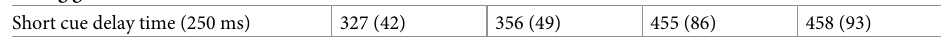
Table 5. Mean reaction times and standard deviations of the spatial oriental task on cue validity effect for short cue delay in the losing game in the moderated mediation sample. Cued Uncued Blue Red Blue Red